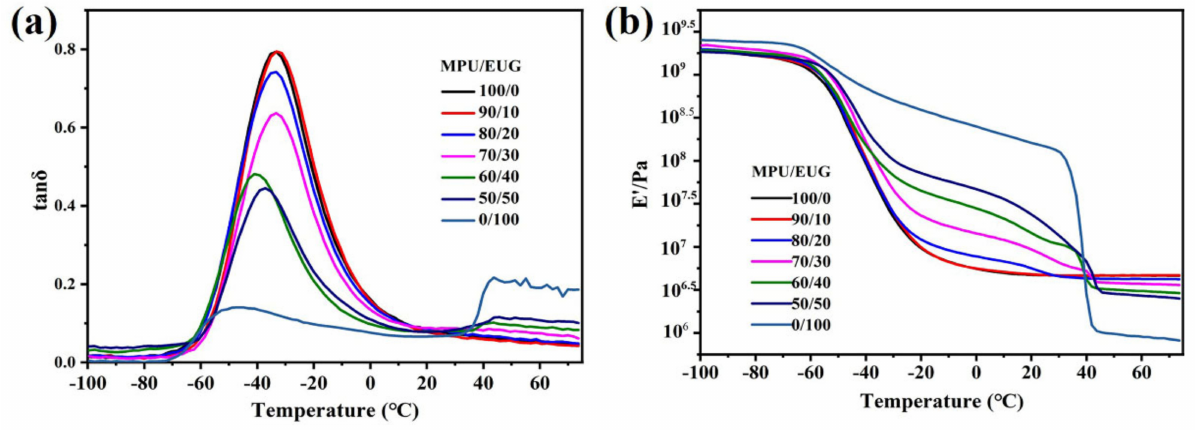
Figure 5. The tan δ -T and E’-T curves of various MPU/EUG composites. ( a ) tan δ -T curves; ( b ) E’-T